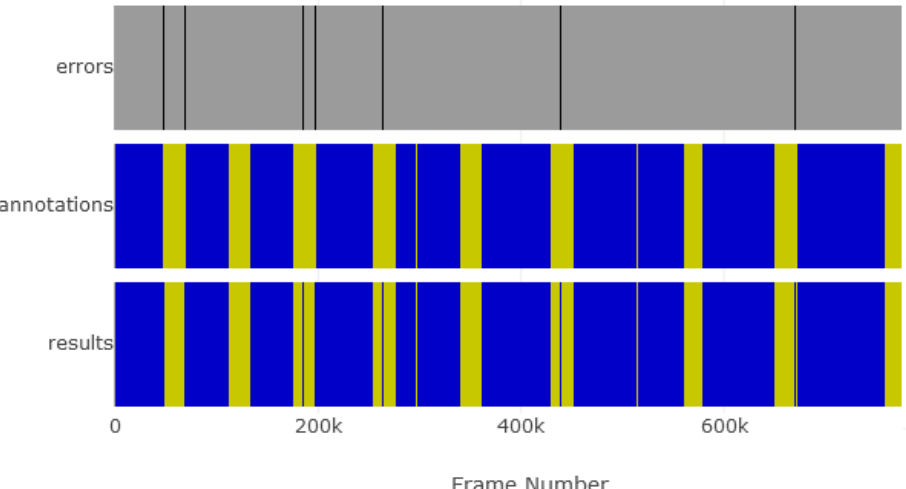
Figure 11. Comparison of the results obtained for the SIC stream with the annotated data, illustrated as black bars the classification